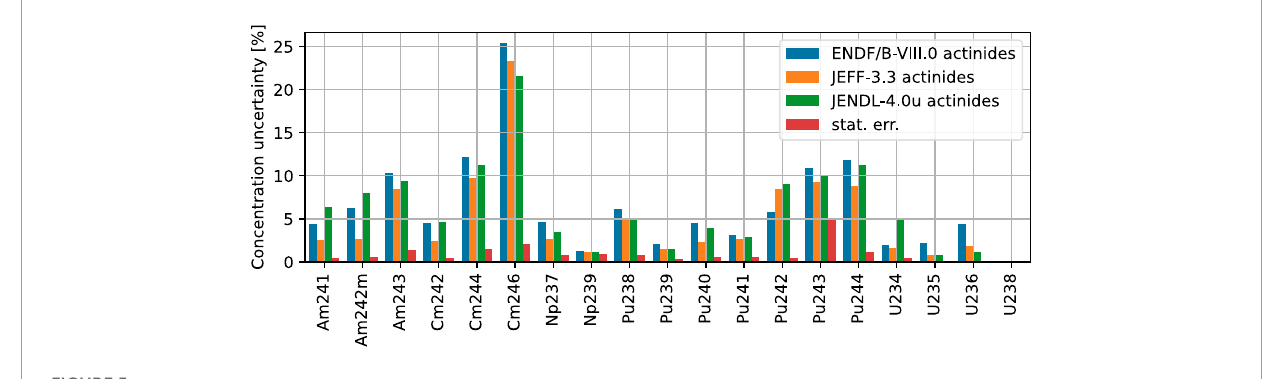
FIGURE 5 Nuclear data uncertainty on actinide composition and comparison with the propagated statistical error inherent to the Monte Carlo method.